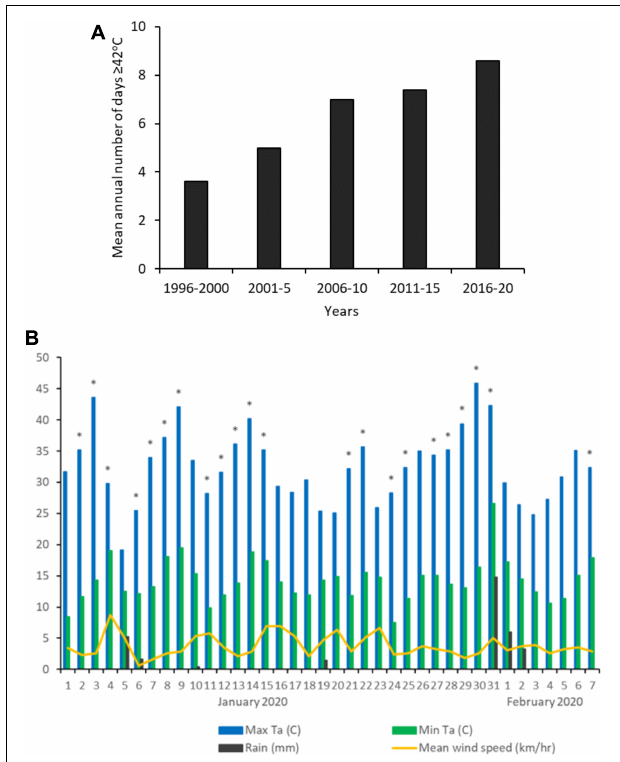
FIGURE 1 | (A) Mean annual number of days when maximum air temperature was ≥ 42 ◦ C, 1996 to 2020 (Renmark; BOM). (B) Weather at the study site during the data collection period (Jan–Feb 2020). Asterisks indicate days upon which behavioral data were